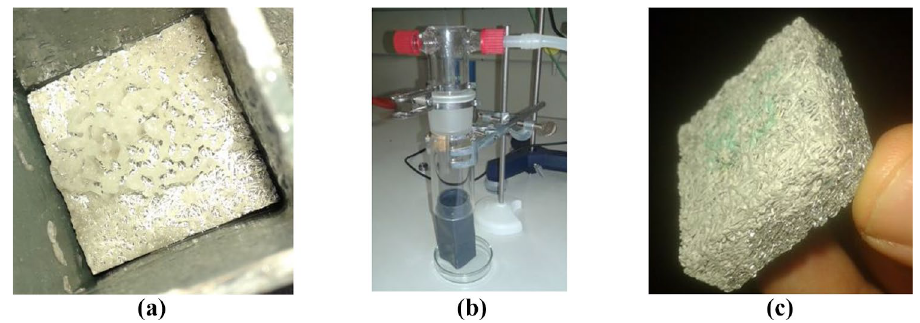
Figure 14. Al 2 (SO 4 ) 3 from acid solution ( a ), synthesis installation ( b ), and result from vapour reaction ( c